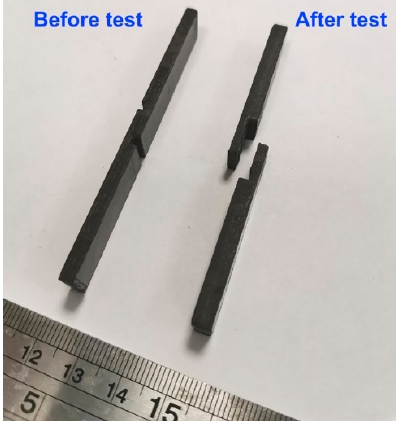
Figure 5. The experimental samples for the in-plane shear strength tests.